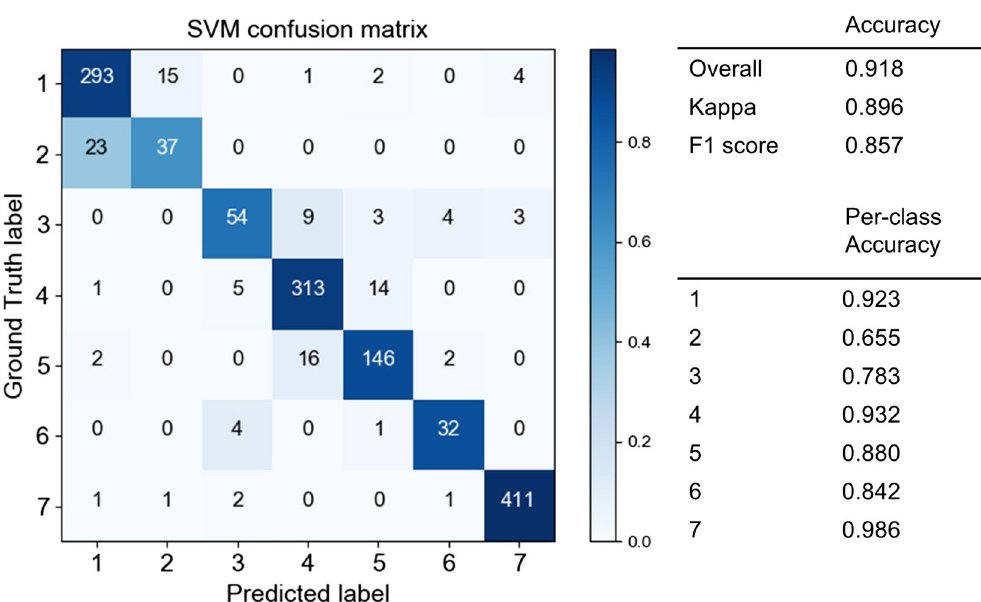
Figure 7. Confusion matrix of SVM in the fall season. (Class 1: deciduous broad-leaved tree; 2: deciduous coniferous tree; 3: evergreen broad-leaved tree; 4: Chamaecyparis obtuse ; 5: Pinus elliottii or Pinus taeda ; 6: Pinus strobus ; 7: